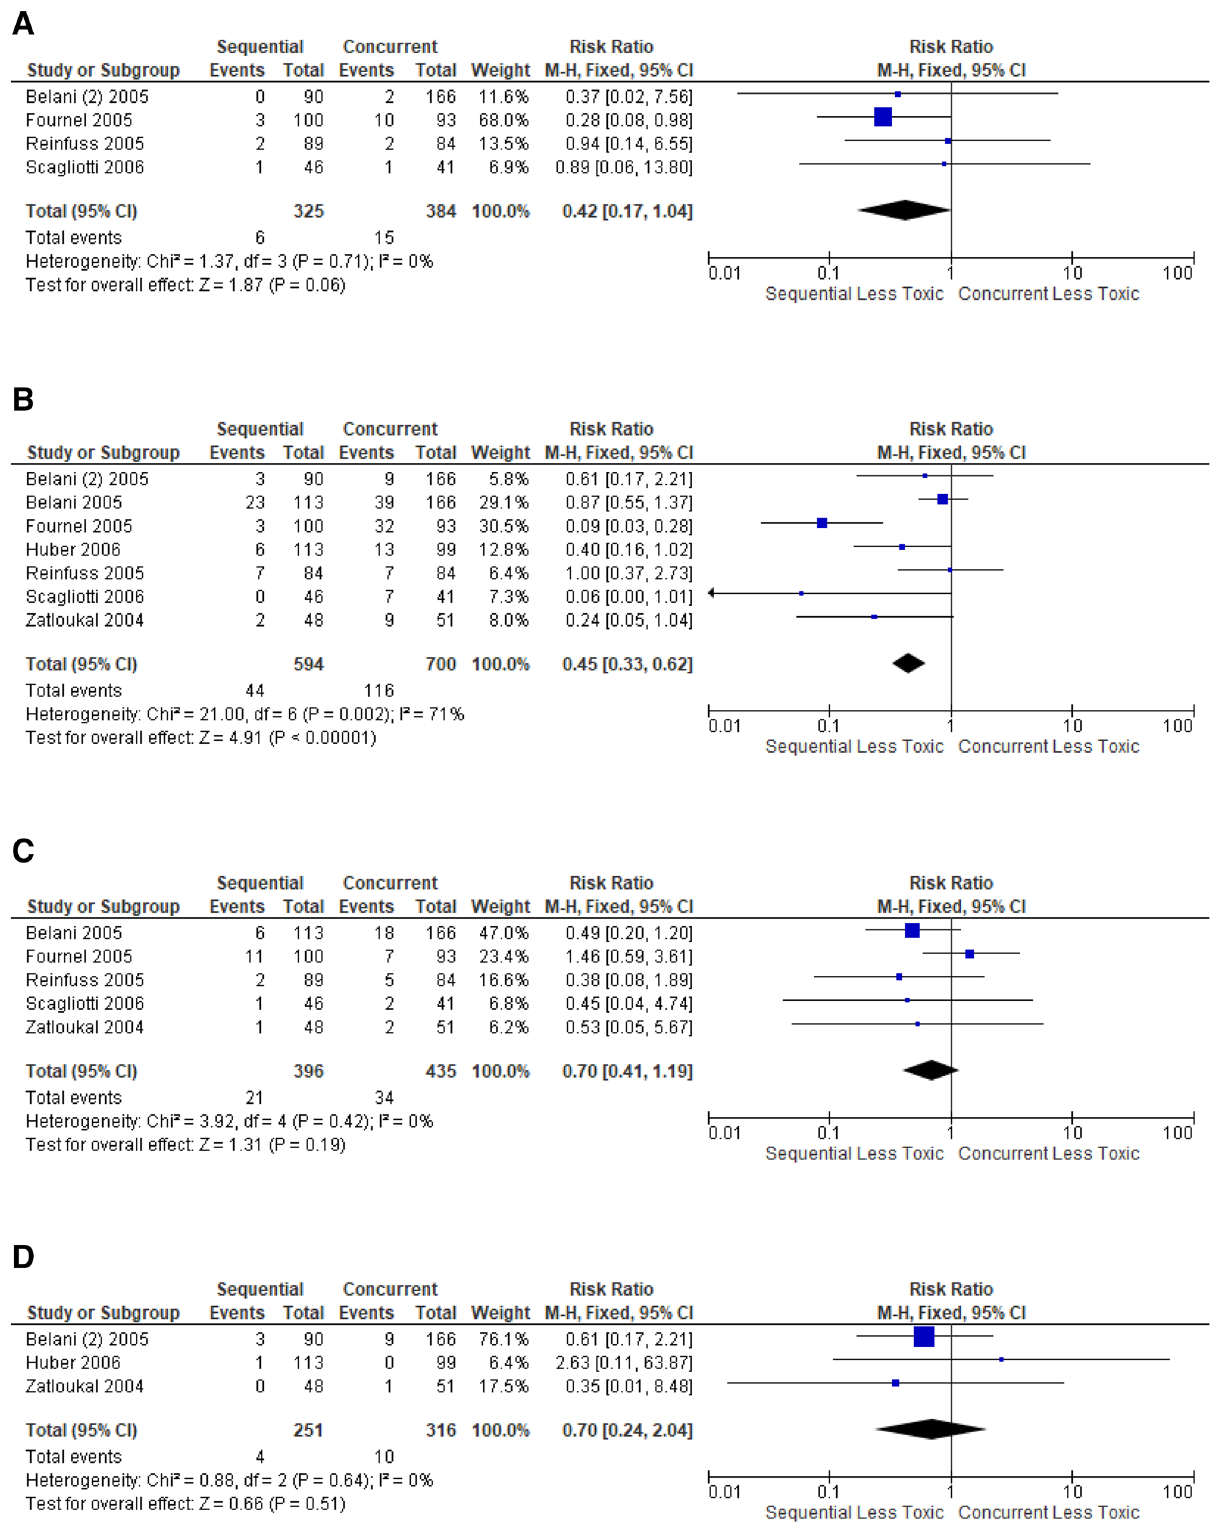
Figure 5. Forest plot showing toxicity risk ratio (RR) for Stage III only studies, comparison between sequential versus concurrent chemoradiation: ( A ) treatment-related deaths; ( B ) grade ≥ 3 oesophagitis; ( C ) grade ≥ 3 pneumonitis; ( D ) grade ≥ 3 cardiac event, generated with Cochrane Review Manager version